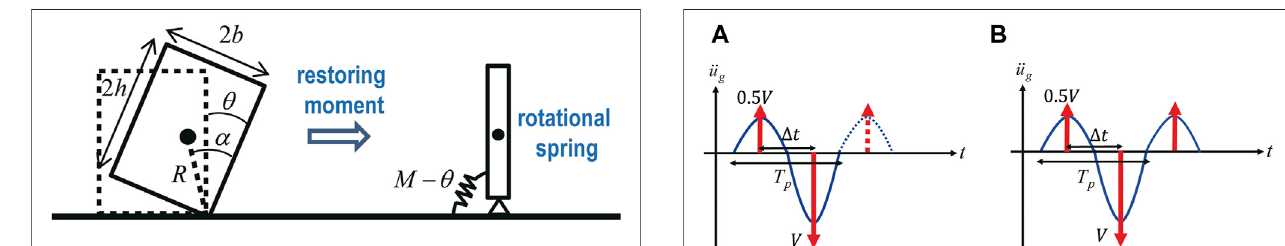
FIGURE 5 | Input motions in numerical examples, (A) Pseudo-triple impulse, consisting of the fi rst two impulses in triple impulse, and